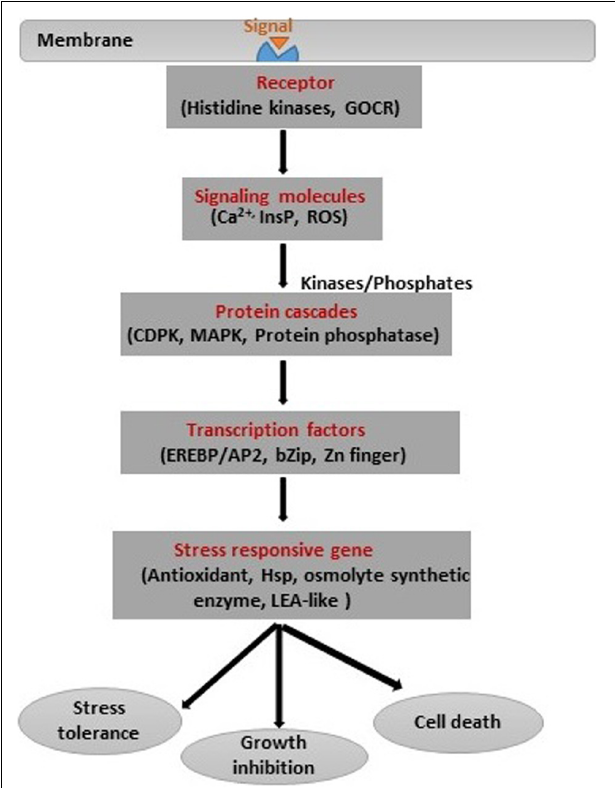
FIGURE 5 | Stress signal transduction and different signaling